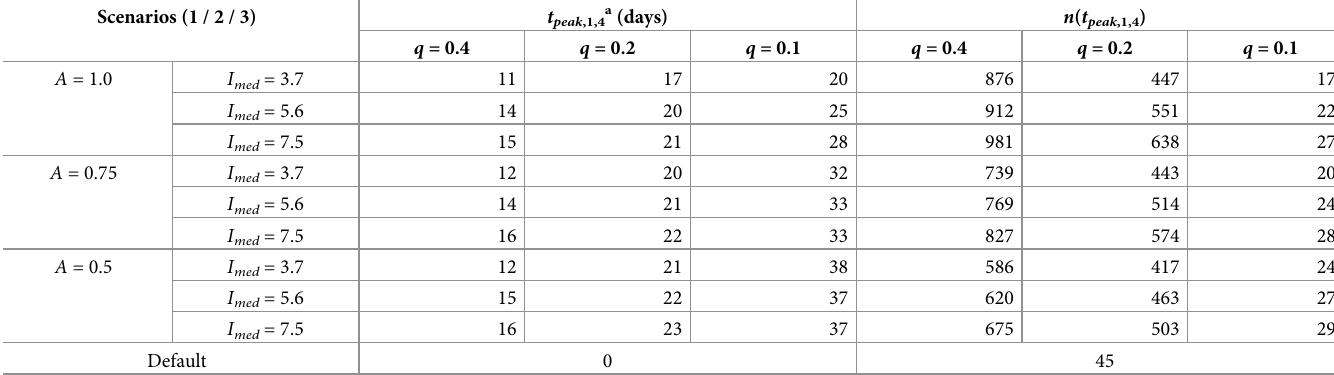
Table 5. Demonstration of the effects of social distancing. Scenarios (1 / 2 / 3)